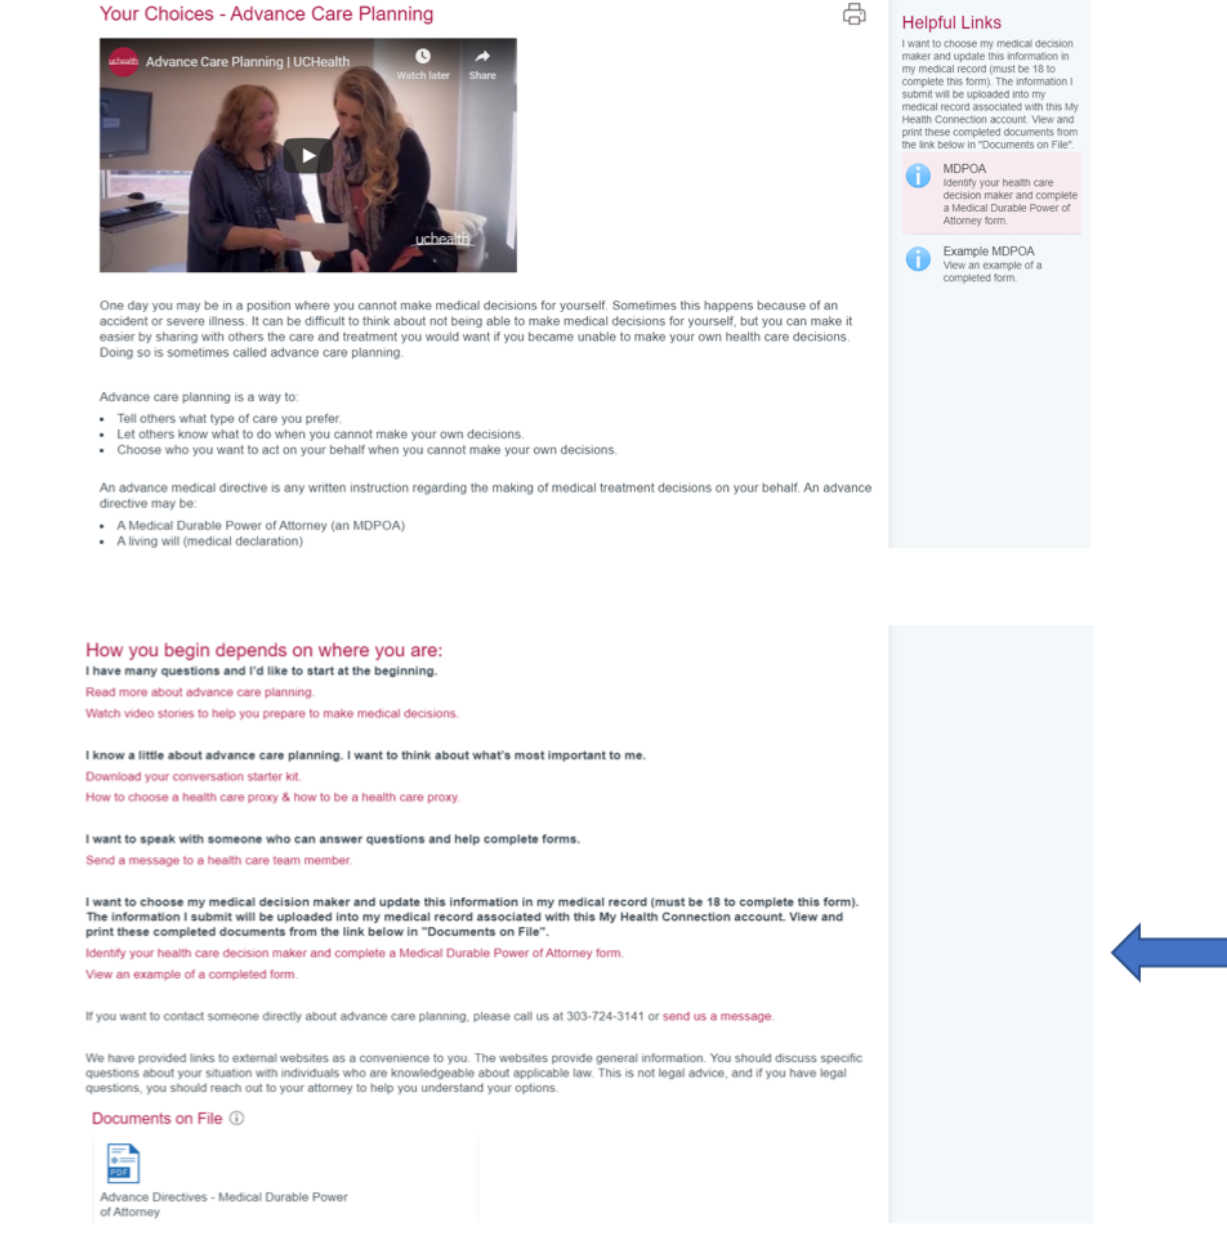
Figure 1. Screenshot of the advance care planning tools in the My Health Connection